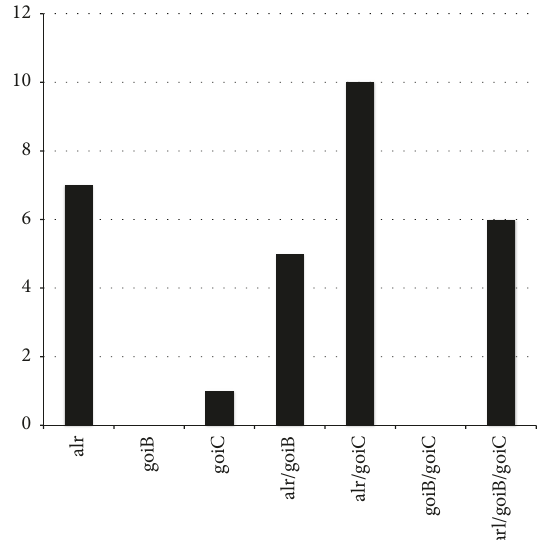
Figure 1: Association among alr , goiB , and goiC genes in a group of 29 samples of DNA extracted by T.